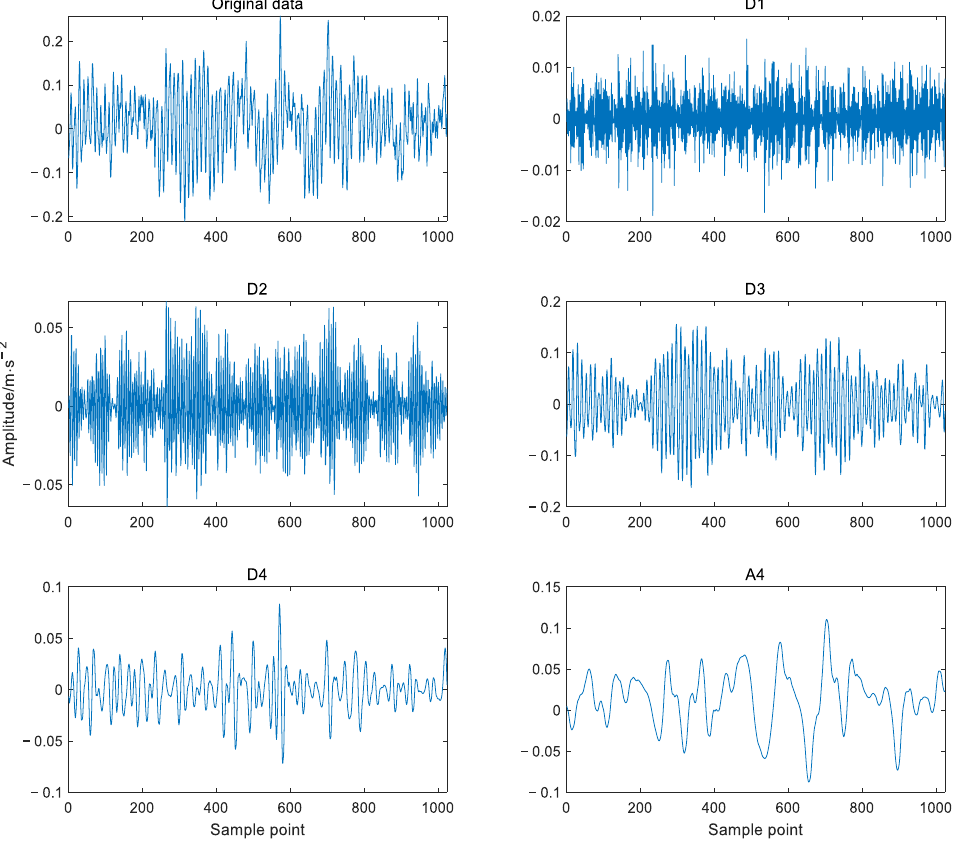
Figure 10. Decomposition of vibration signal based on DWT.